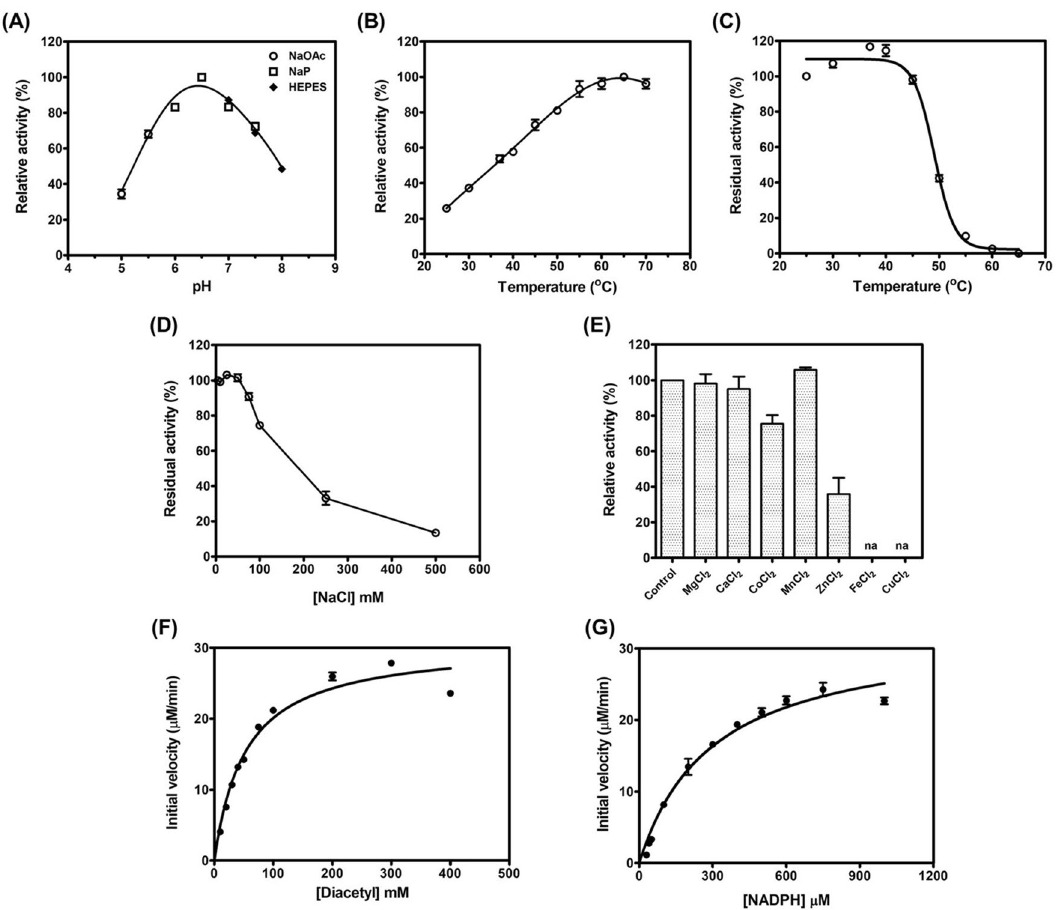
Figure 5. Enzymatic characterization of BPSS2242. Effects of ( A ) pH and ( B ) temperature on enzyme activity. NaOAc: sodium acetate; NaP: sodium phosphate. ( C ) Thermal stability analysis of BPSS2242. Effects of ( D ) NaCl and ( E ) metal ions on the enzyme activity. Control is the reaction without metal ion. na: no activity. Kinetic plots of BPSS2242 for ( F ) diacetyl and ( G ) NADPH.